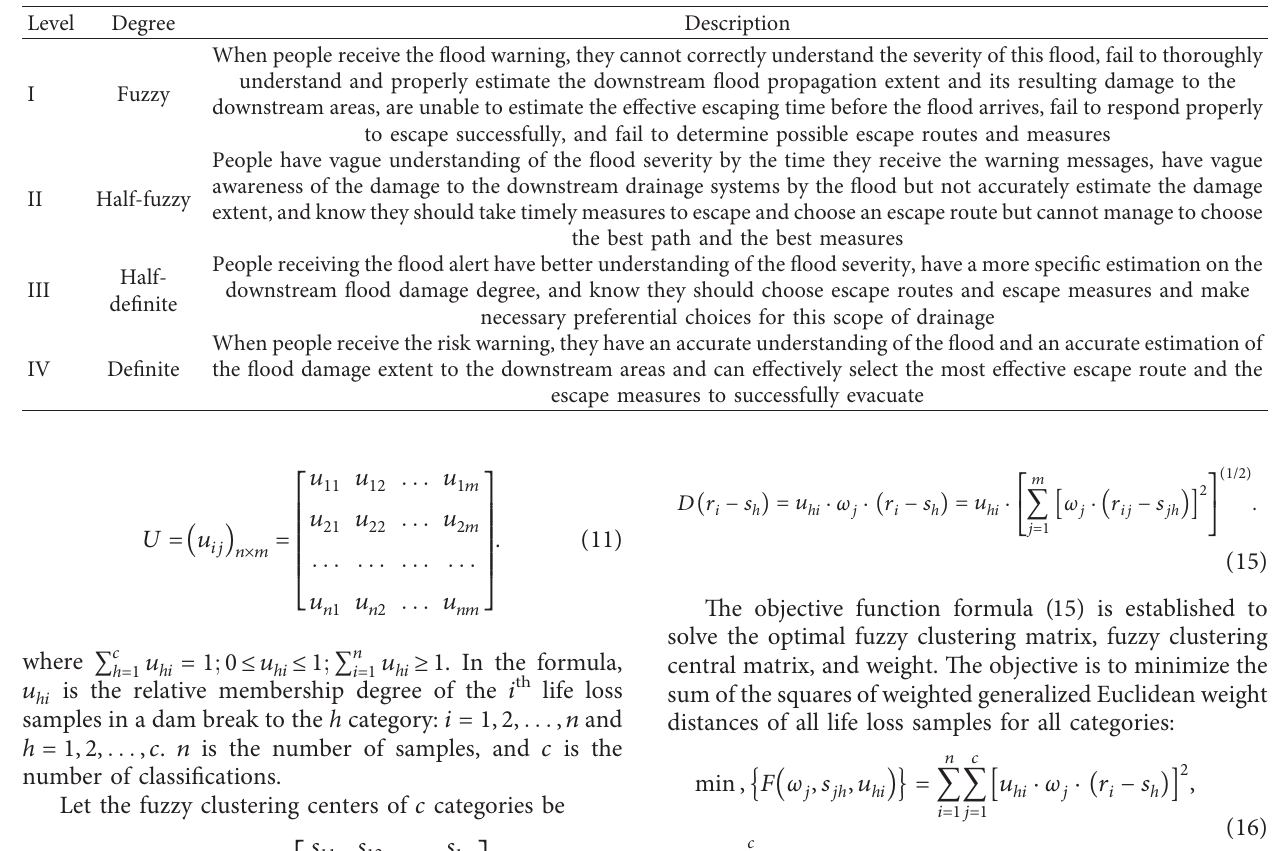
Table 1: Degree of